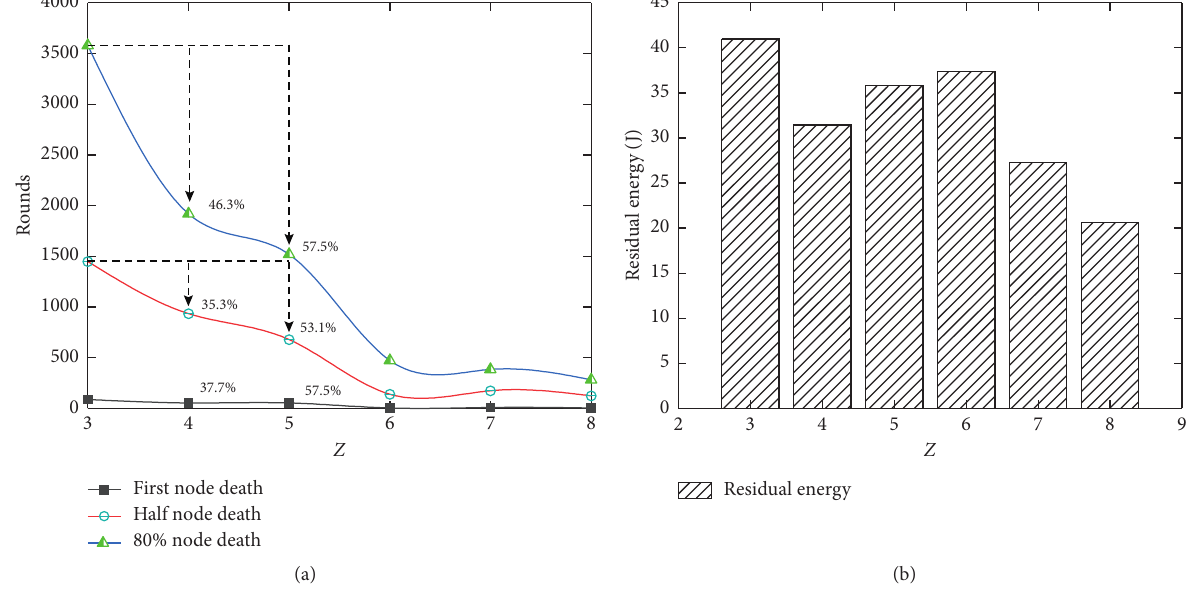
Figure 6: Relationships between z and assessment metrics: (a) influence of z on death round and (b) influence of z on residual energy.